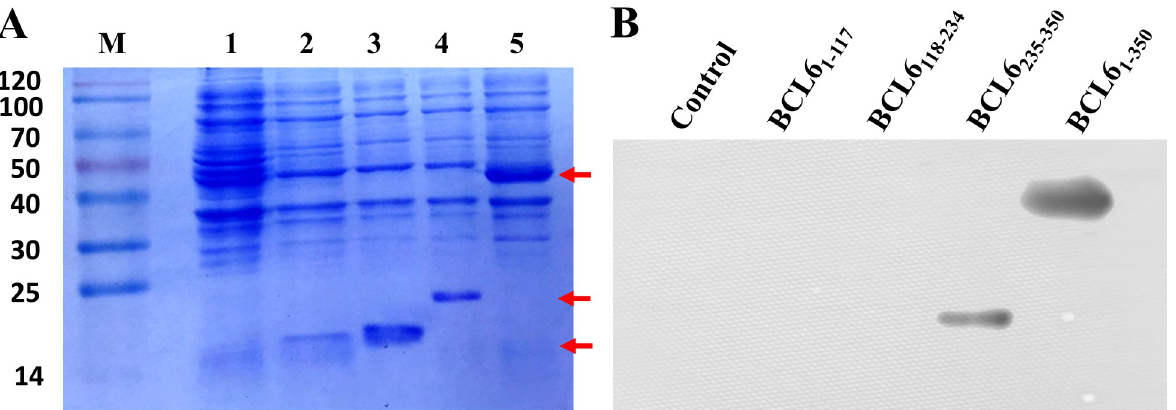
Fig 5. The epitope analysis of BCL6 for 1E6A4 mAb. (A) SDS-PAGE analysis of BCL6 1-350 fragments expression in E . coli . M: Marker (Blue plus II protein marker); lane 1: Control; lane 2: BCL6 1-117 ; lane 3: BCL6 118-234 ; lane 4: BCL6 235-350 ; lane 5: BCL6 1-350 . (B) The epitope of BCL6 for 1E6A4 mAb was determined by western